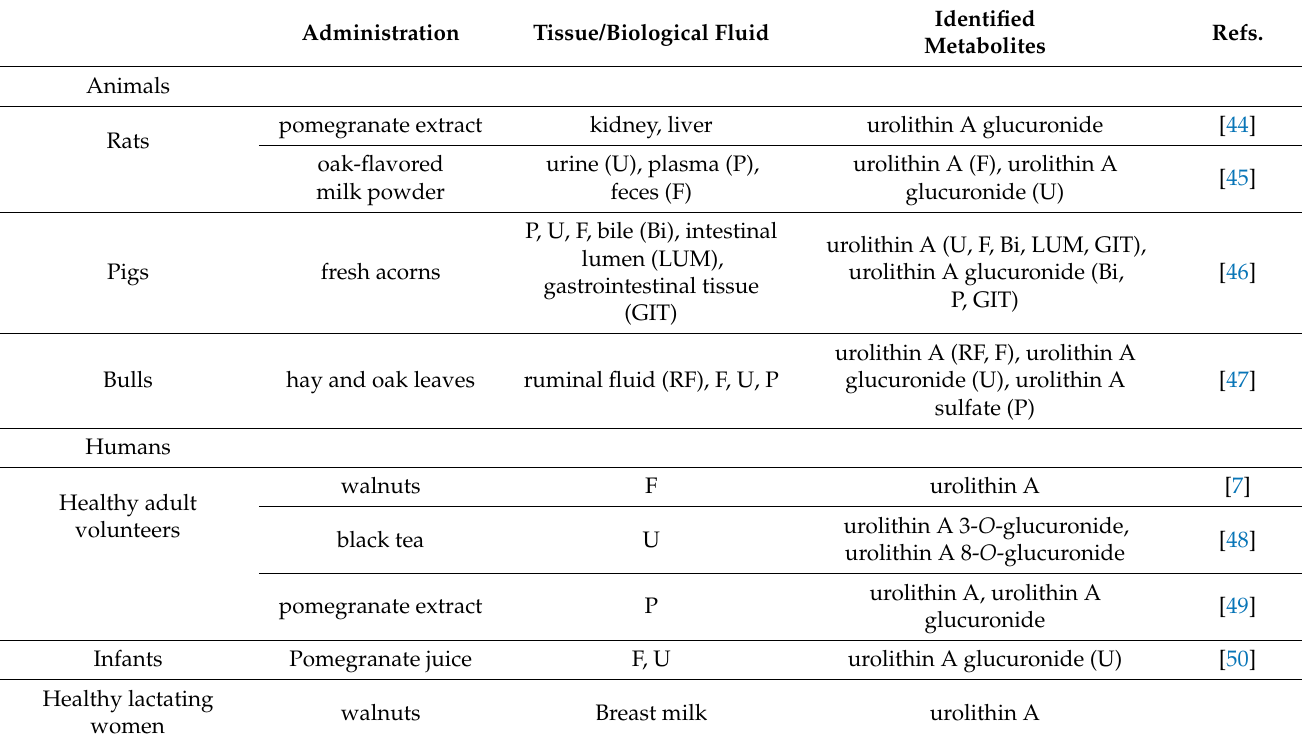
Table 3. Distribution of urolithin A and its conjugate metabolites in biological fluids and tissues. Administration Tissue/Biological Fluid